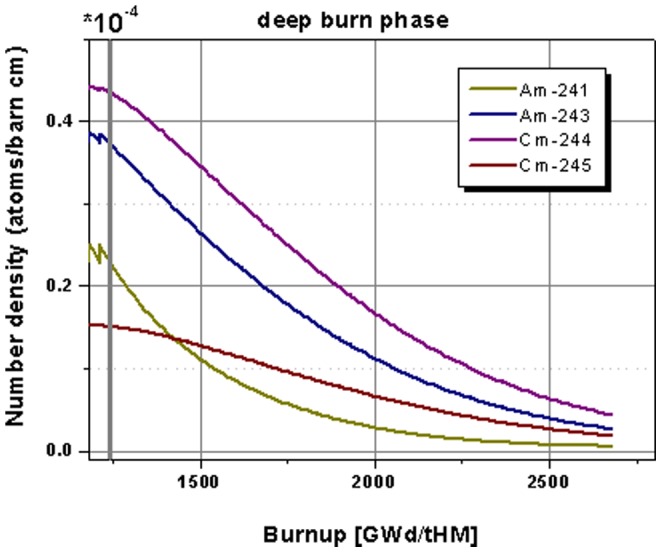
Highlight on the evolution of the minor actinide isotope inventory for the continuation in the deep burn phase.